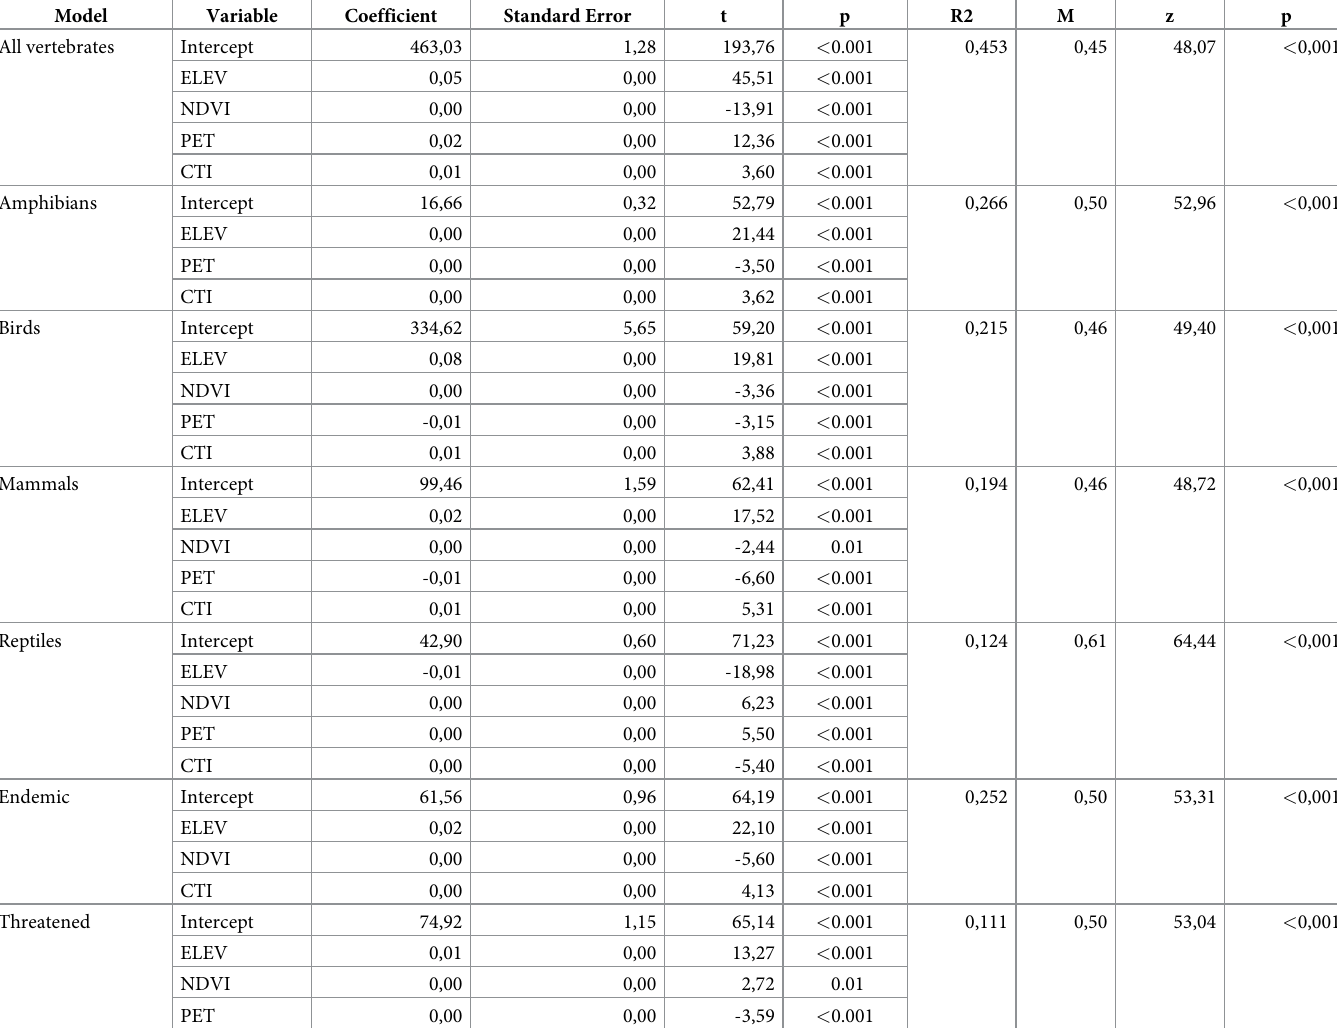
Table 3. Ordinary least squares regression models parameters and variation explained (R2) by topographic, vegetation and environmental variables as regressor for all vertebrates and for endemic and threatened species richness in Colima, Mexico. Spatial correlation test: M = Moran’s index, z = z-score.